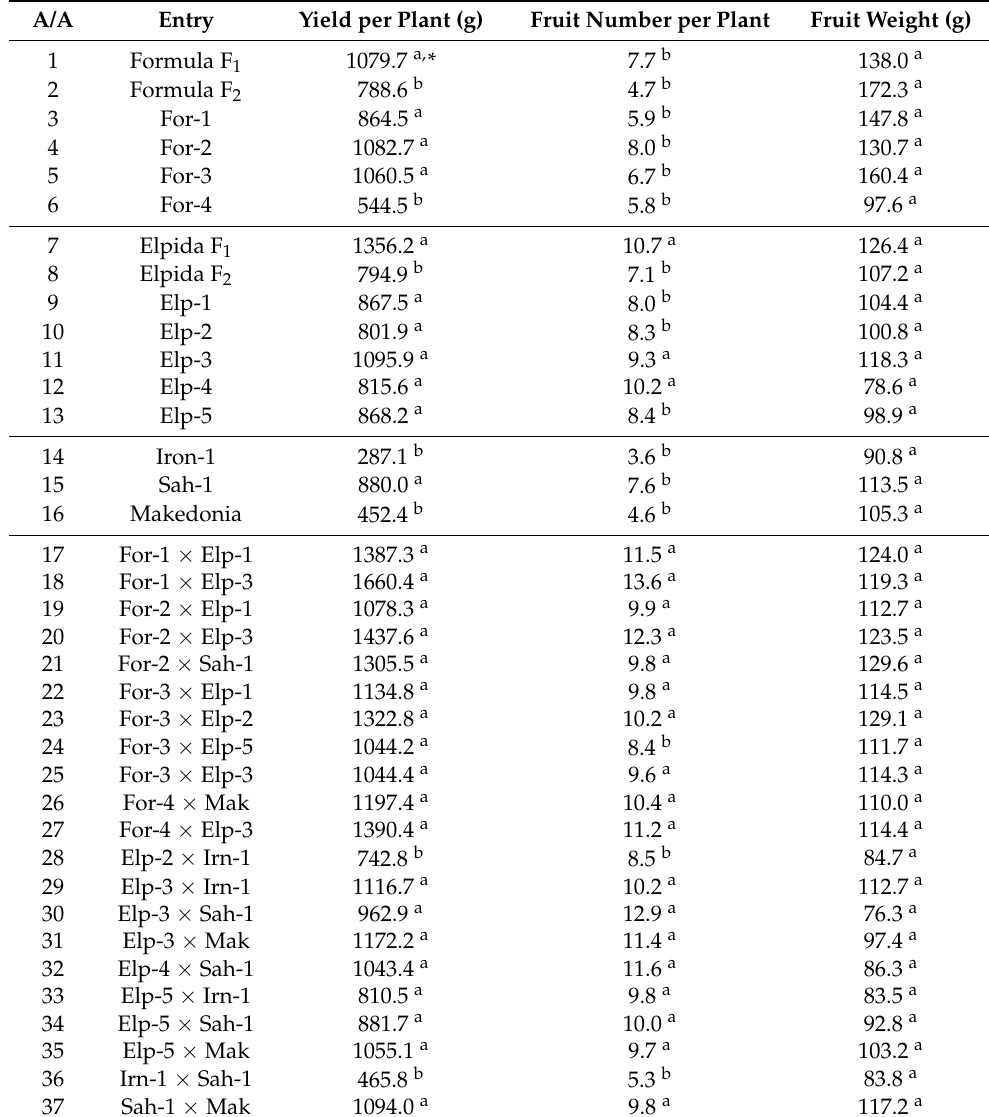
Table 1. Early production for yield per plant (g), fruit number per plant, and fruit weight (g) of the original F 1 commercial hybrids, new recombinant inbred lines, and the new reconstructed